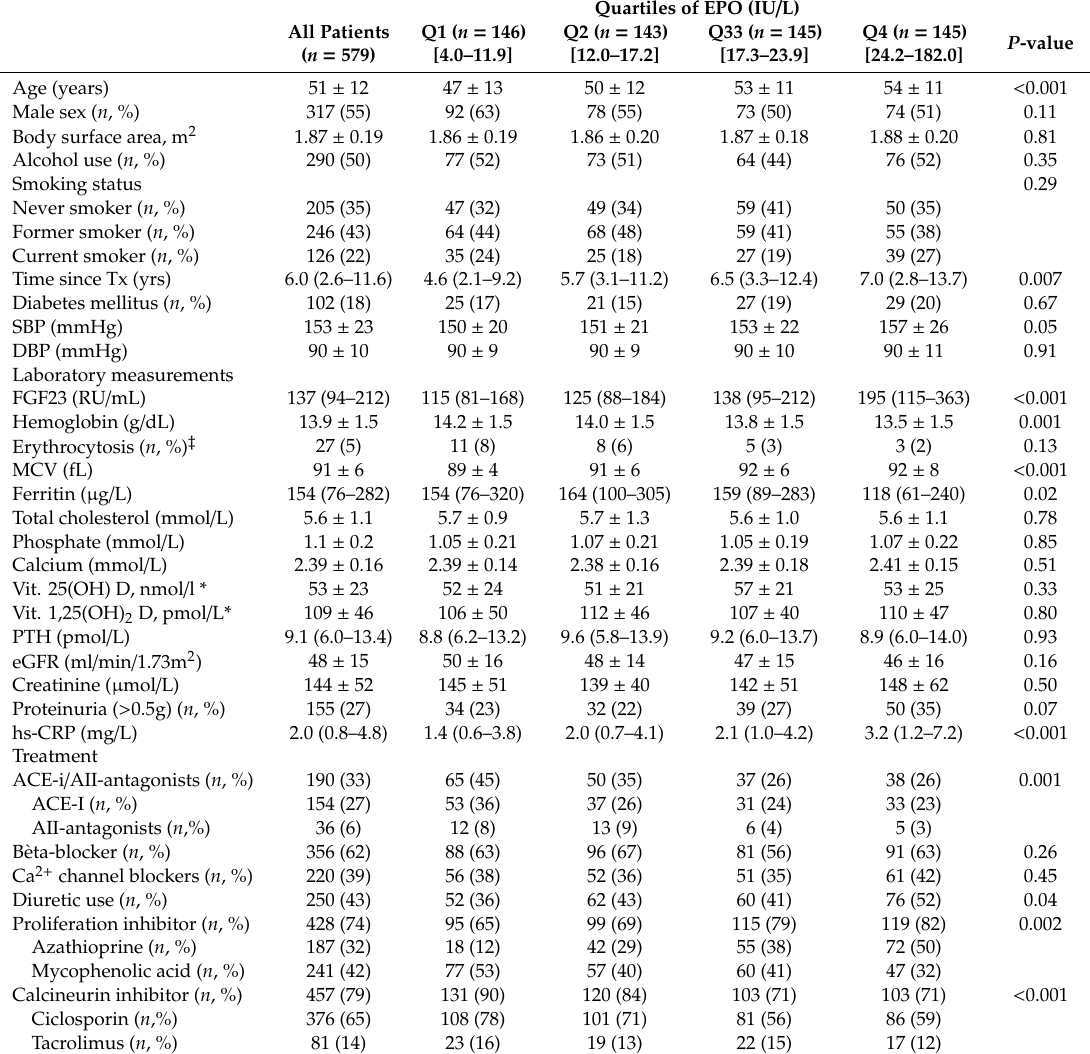
Table 1. Baseline characteristics of the included 579 renal transplant recipients (RTRs) across erythropoietin (EPO)